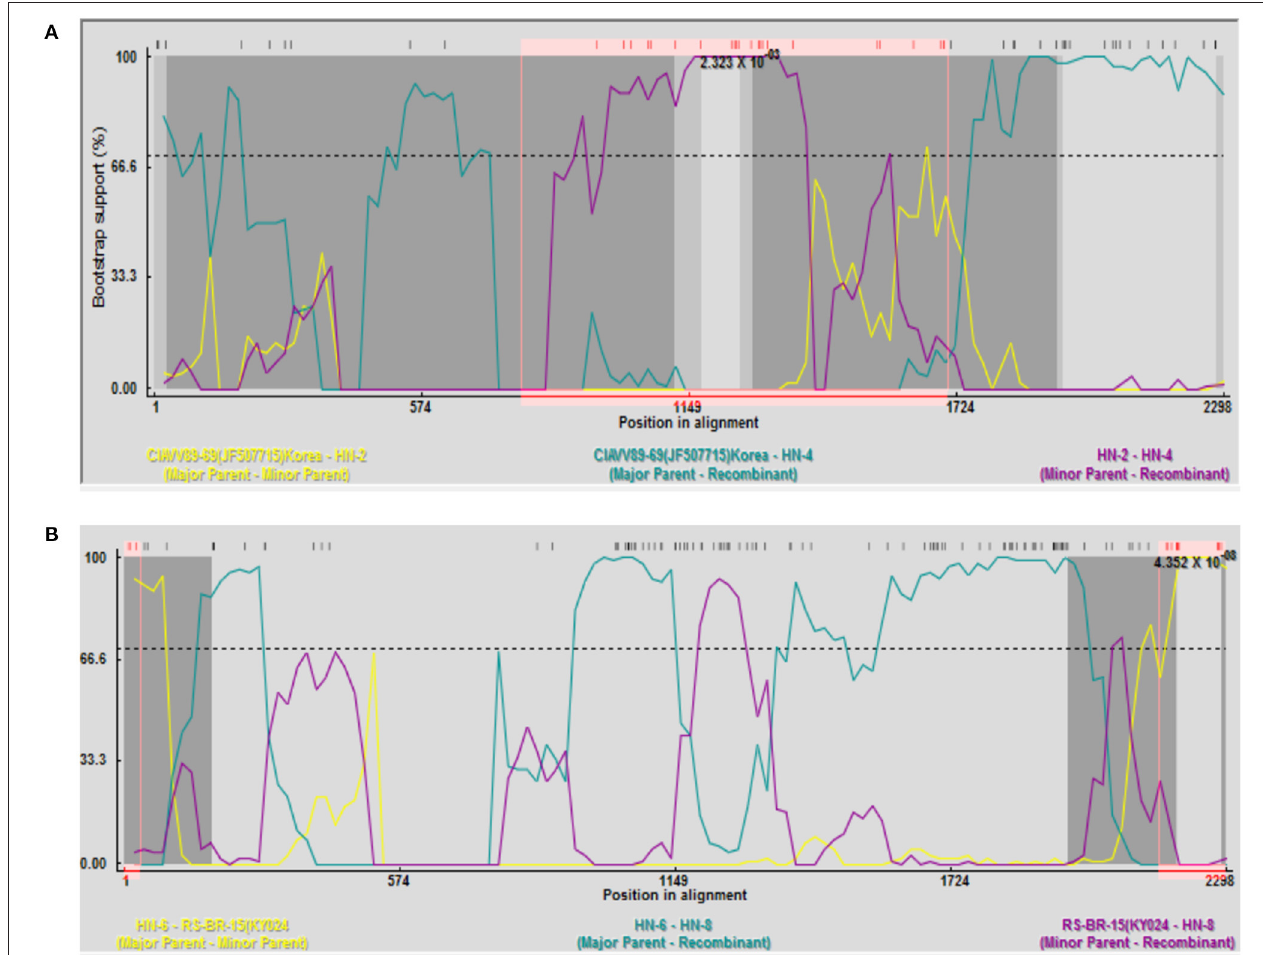
FIGURE 2 | Recombination analysis of the (A) HN-4 strain; and (B) HN-8 strain. (A) Bootscan analysis of HN-4 strain and sequences of primary and secondary parents. Korean strain CIAVV89-69 was the main parent, and Henan strain HN-2 was the secondary parent, whose recombinant breakpoints were mapped to sites 787 and 1707. Bootscan analysis of HN-8 strain and sequence of primary and secondary parents. Henan strain HN-6 was the main parent, and Brazilian strain RS-BR-15 was the secondary parent, whose recombinant breakpoints were mapped to sites 36 and